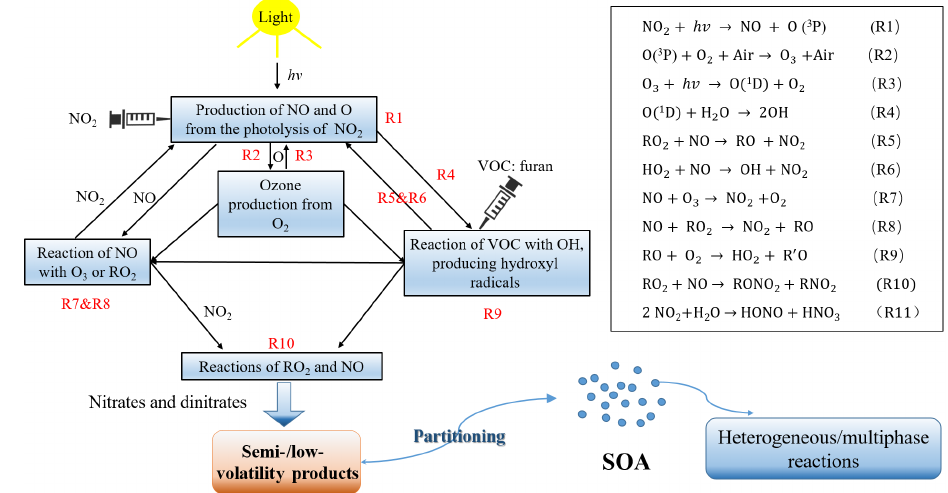
Figure 1. Major chemical reactions during the experiments.